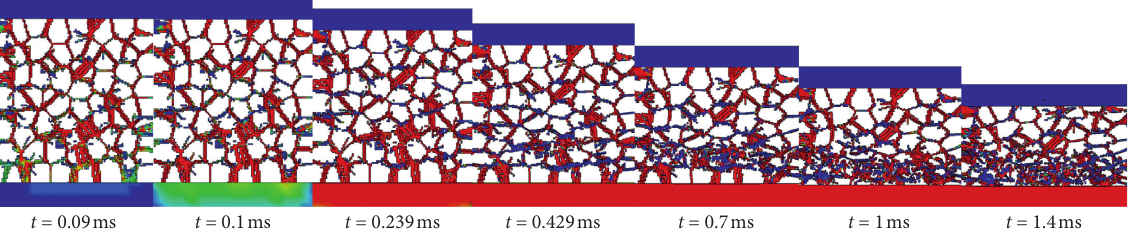
Figure 13: Cloud image of foam aluminum compression process.